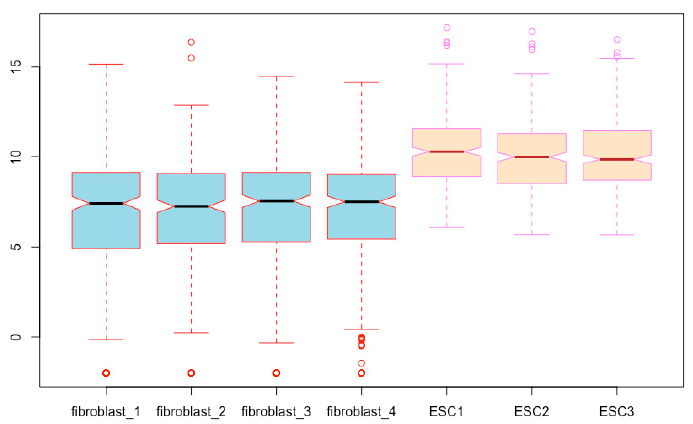
Figure 18. Modify some parts of boxplot by overriding features defined by the border function.